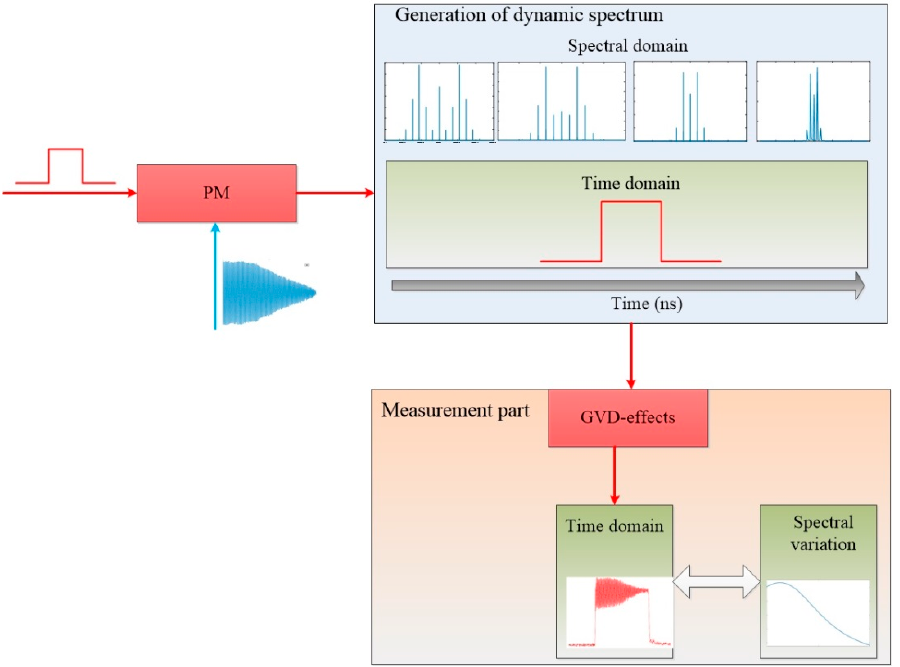
Figure 1. Diagram of the proposed specific phase modulation. PM: Phase modulator.